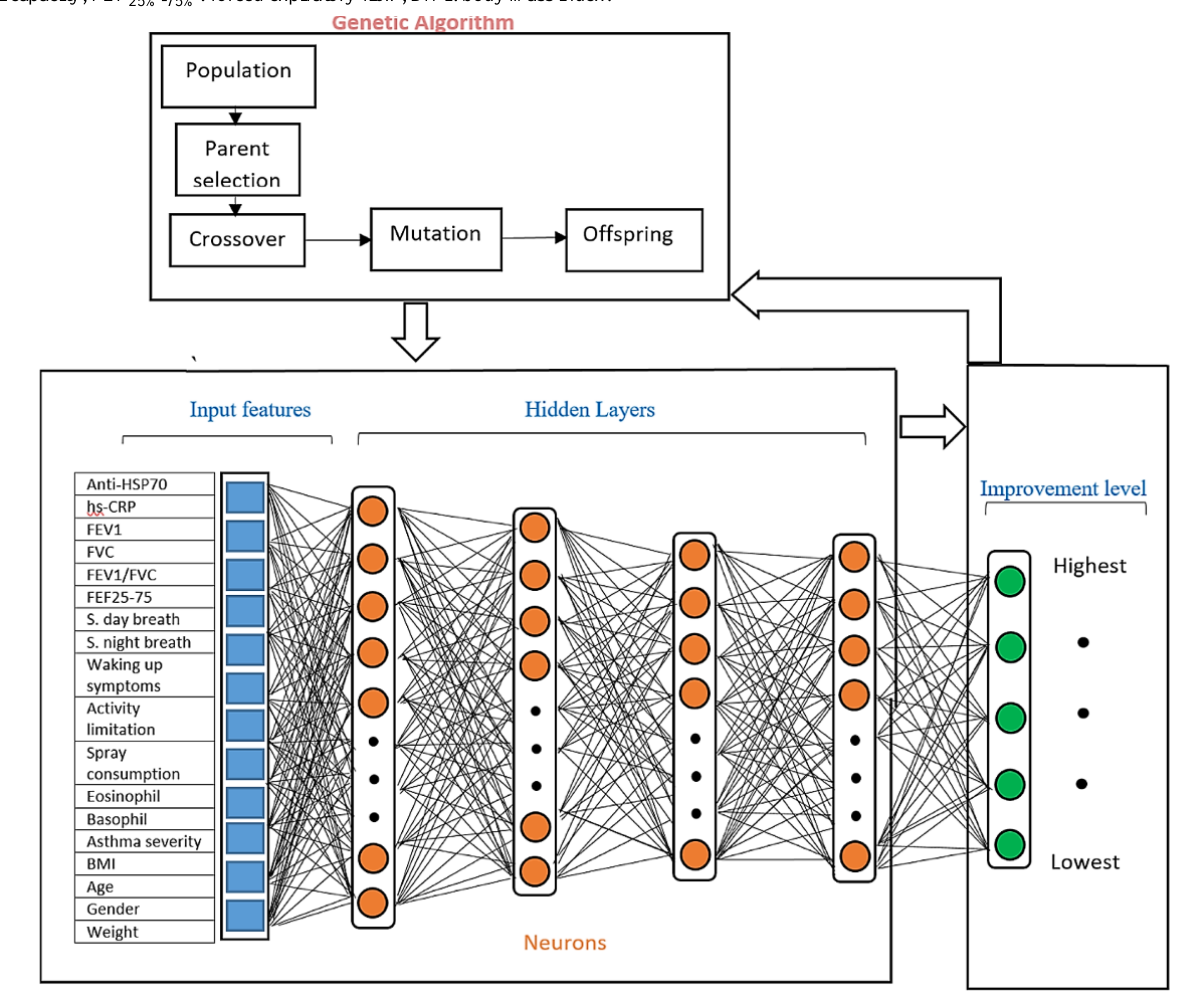
Figure 2. The architecture of the genetic algorithm–modified neural network system for predicting C sativus L supplement effects on patients with allergic asthma. Anti-HSP: anti-heat shock protein; hs-CRP: high sensitivity C-reactive protein; FEV 1 : forced expiratory volume in 1 s; FVC: forced vital capacity; FEF 25%-75% : forced expiratory flow; BMI: body mass